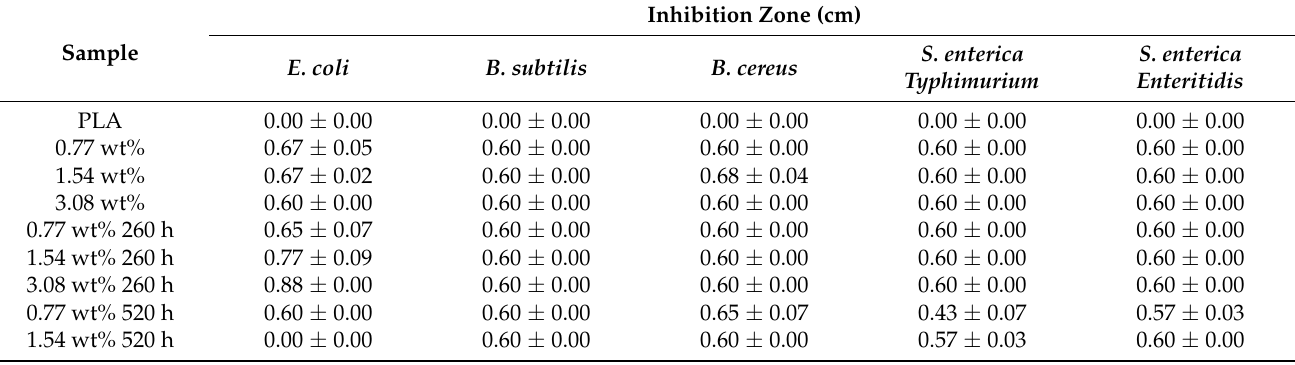
Table 7. Inhibition zone of PLA and SiCO modified PLA composites